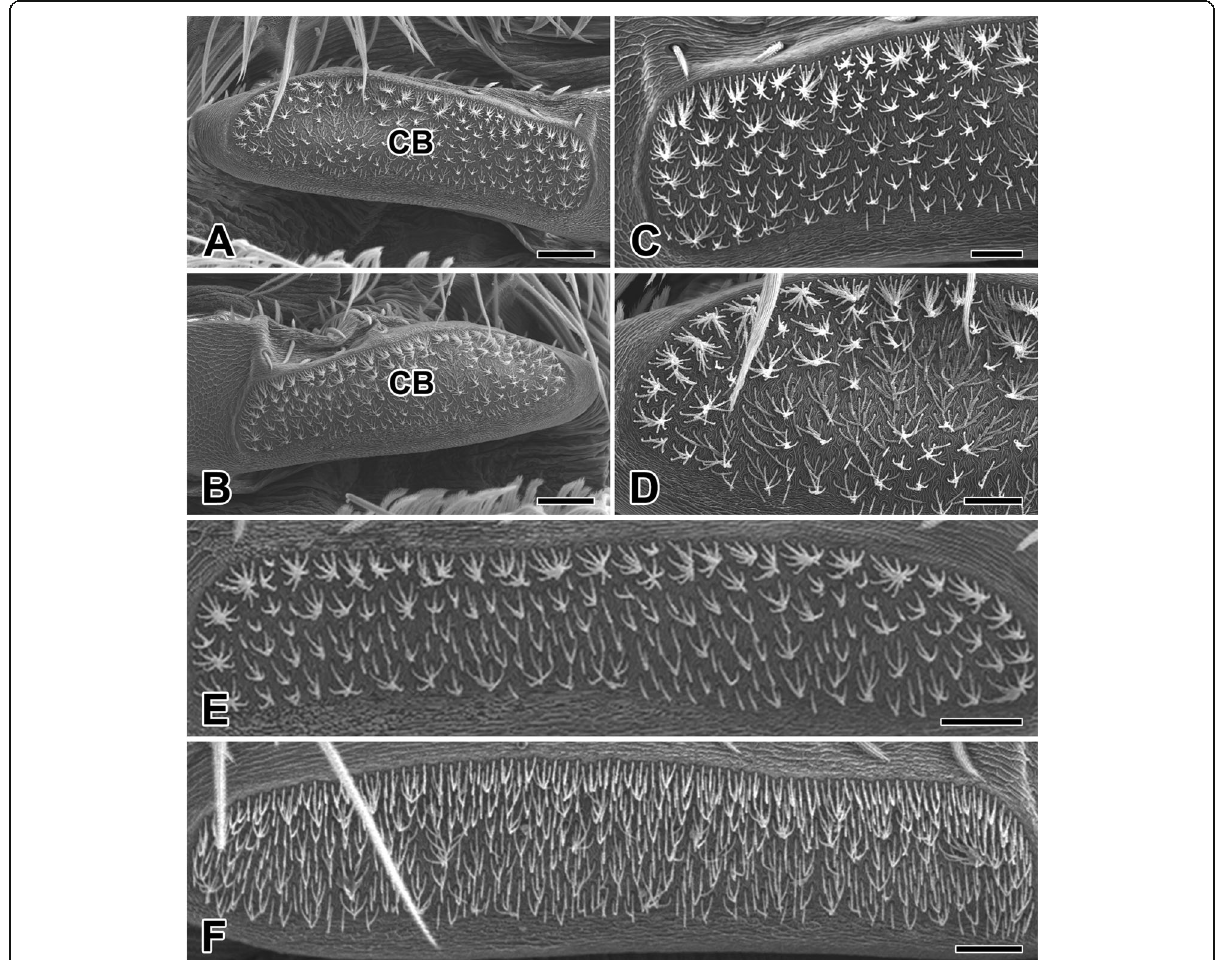
Fig. 2 Scanning electron micrographs of the cribellum in the spider N. albofasciata . a, b The cribellar silk spinning system consists of bipartite cribellum (CB) plate which divided with left and right spinning fields. c, d A pair of cribellar plate with hundreds to thousands outlets are medially divided to form a symmetrical distribution of spinning apparatuses. e, f The surface of the cribellum is covered by numerous elongate spigots which producing numerous cribellate silk fibrils. Scale bars indicate 50 μ m ( a, b ) and 20 μ m ( c-f